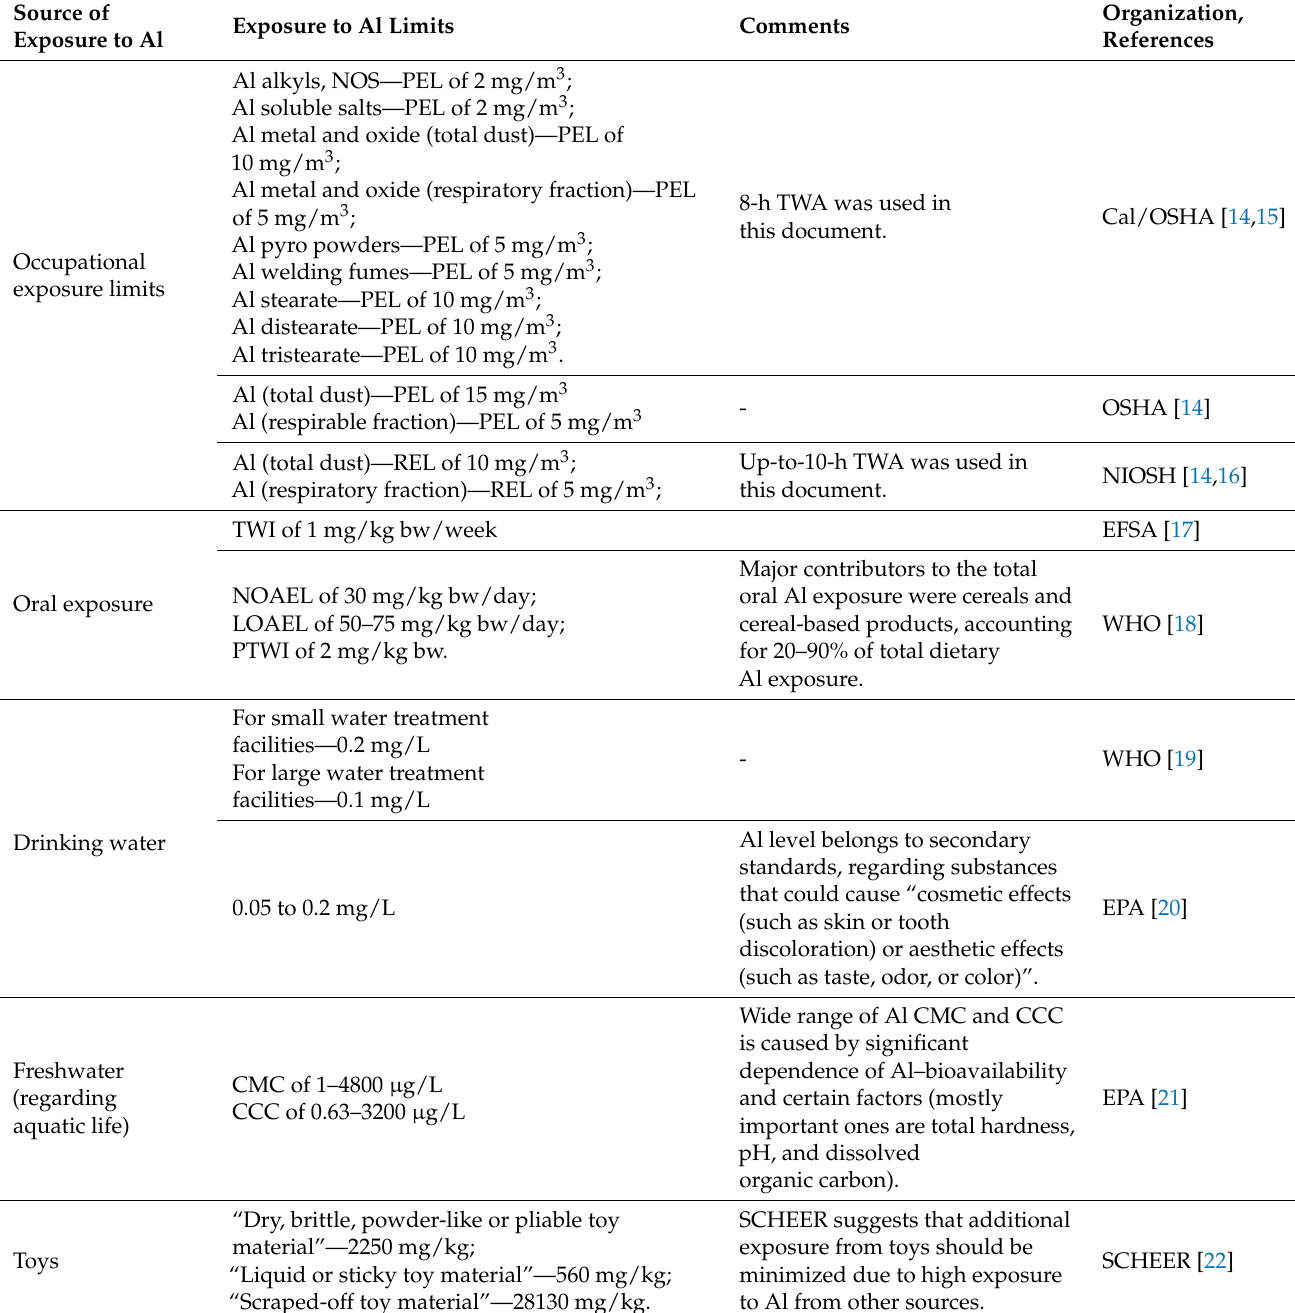
Table 1. Examples of recommendations regarding aluminium exposure